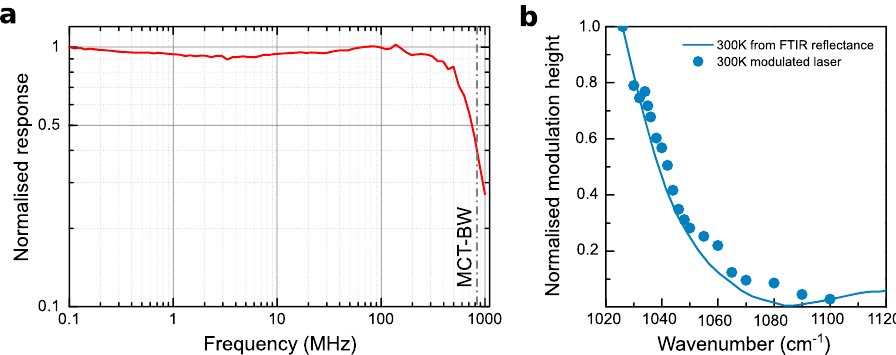
Fig. 4 Polariton-based amplitude modulator bandwidth at 300 K. a Normalized response at room-temperature of the small device ( p = 4.1 μ m) when fed with 10 dBm/DC@ − 989mV. The QC laser frequency is 1010 cm − 1 . The nominal − 3 dB cutoff at 837 MHz of the fast MCT is shown as a gray dashed vertical line. The entire experiment is automated by an homemade python code, based on the Pymeasure package (https://pymeasure.readthedocs.io/en/ latest/). b Normalized modulation height as a function of the QC laser frequency (dots). The measurements are performed on the large devices (surface is 5 × 10 4 μ m 2 , p = 4.2 μ m). The QC laser frequency is tuned between 1026 and 1100 cm − 1 and the modulated beam is detected by the 50 MHz MCT and the lock-in. The modulator is fed with a 0 – 3 V sinusoidal signal at 100 kHz. The solid line is the modulation height for 3 V bias of Fig. 2(c), normalized to 1 at 1026 cm − 1 . The perfect overlap proves that the origin of the modulation is indeed the transition from the strong light-matter coupling regime towards the